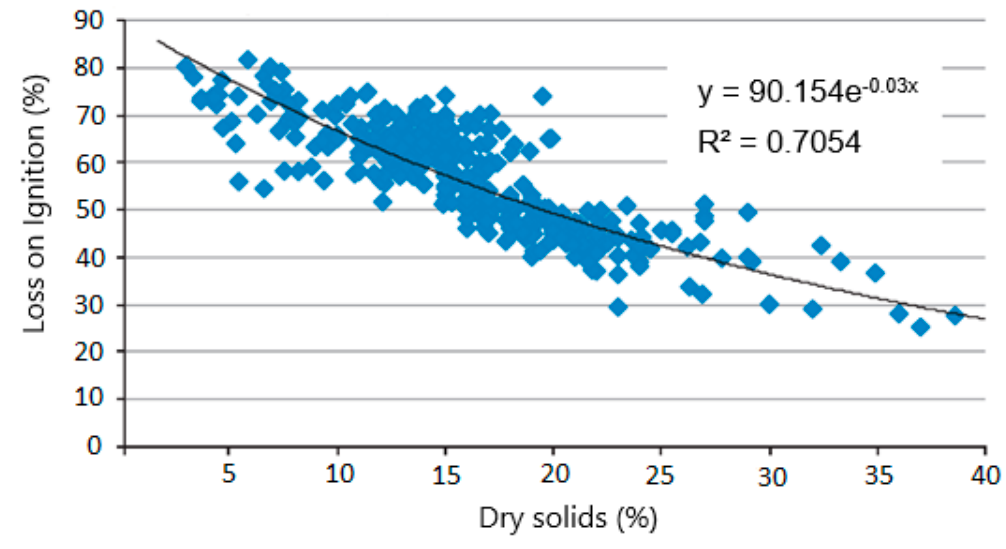
Figure 2. Organic matter content (loss on ignition—LOI) in the feed sludge and dry solids content in the residual sludge—correlation in STRBs. Practical experiences indicate that a LOI higher than 65% significantly limits sludge dewatering.